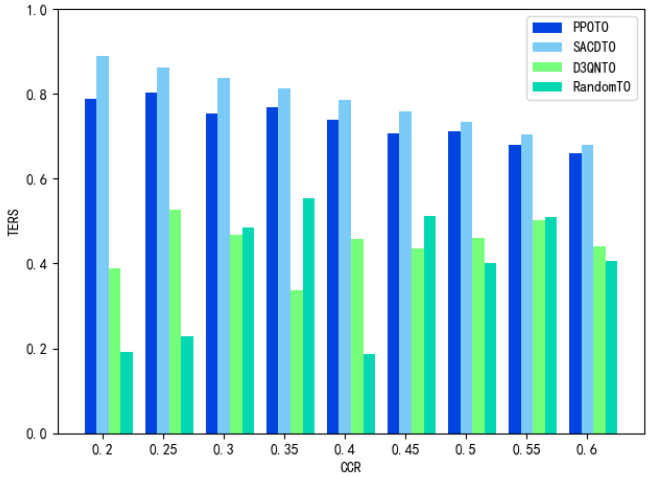
Figure 6. The Effect of CCR on TERS.